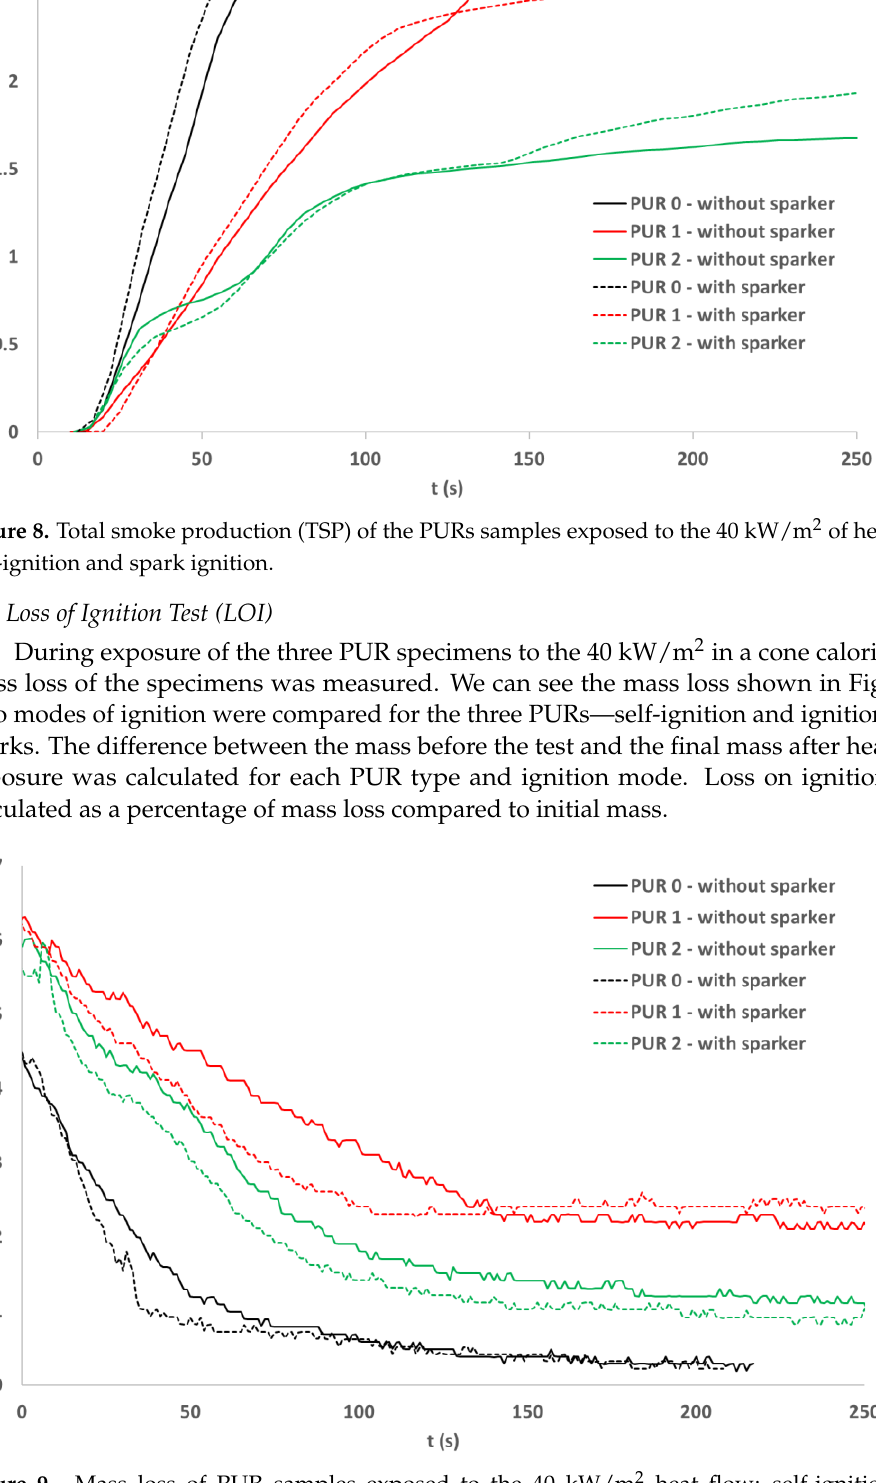
Figure 7. Smoke production rate (SPR) of the PURs samples exposed to the 40 kW/m 2 of heat flux; self-ignition and spark ignition.